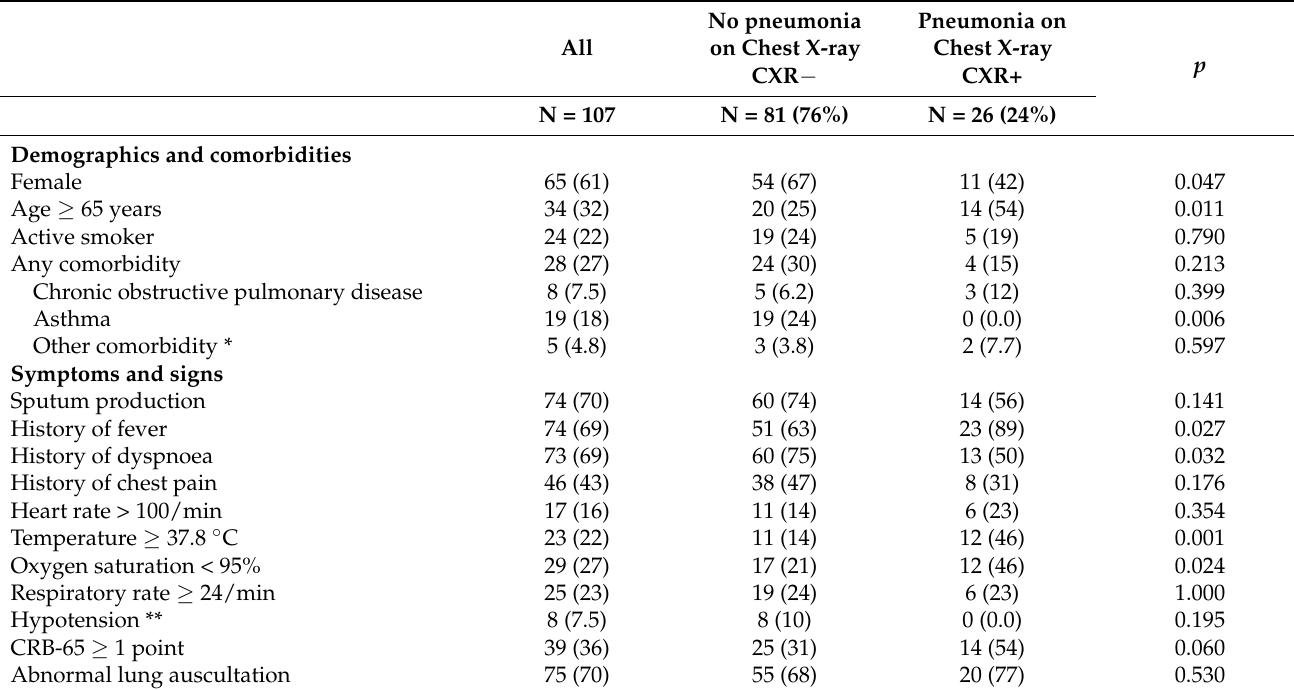
Table 1. Patients’ characteristics according to the presence of pneumonia visible on chest X-ray.